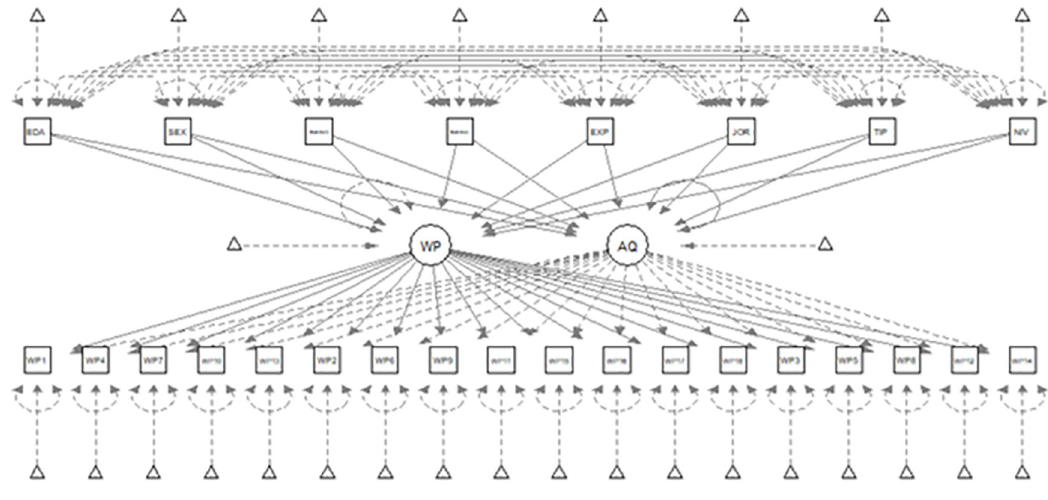
Fig 2. Predictive model